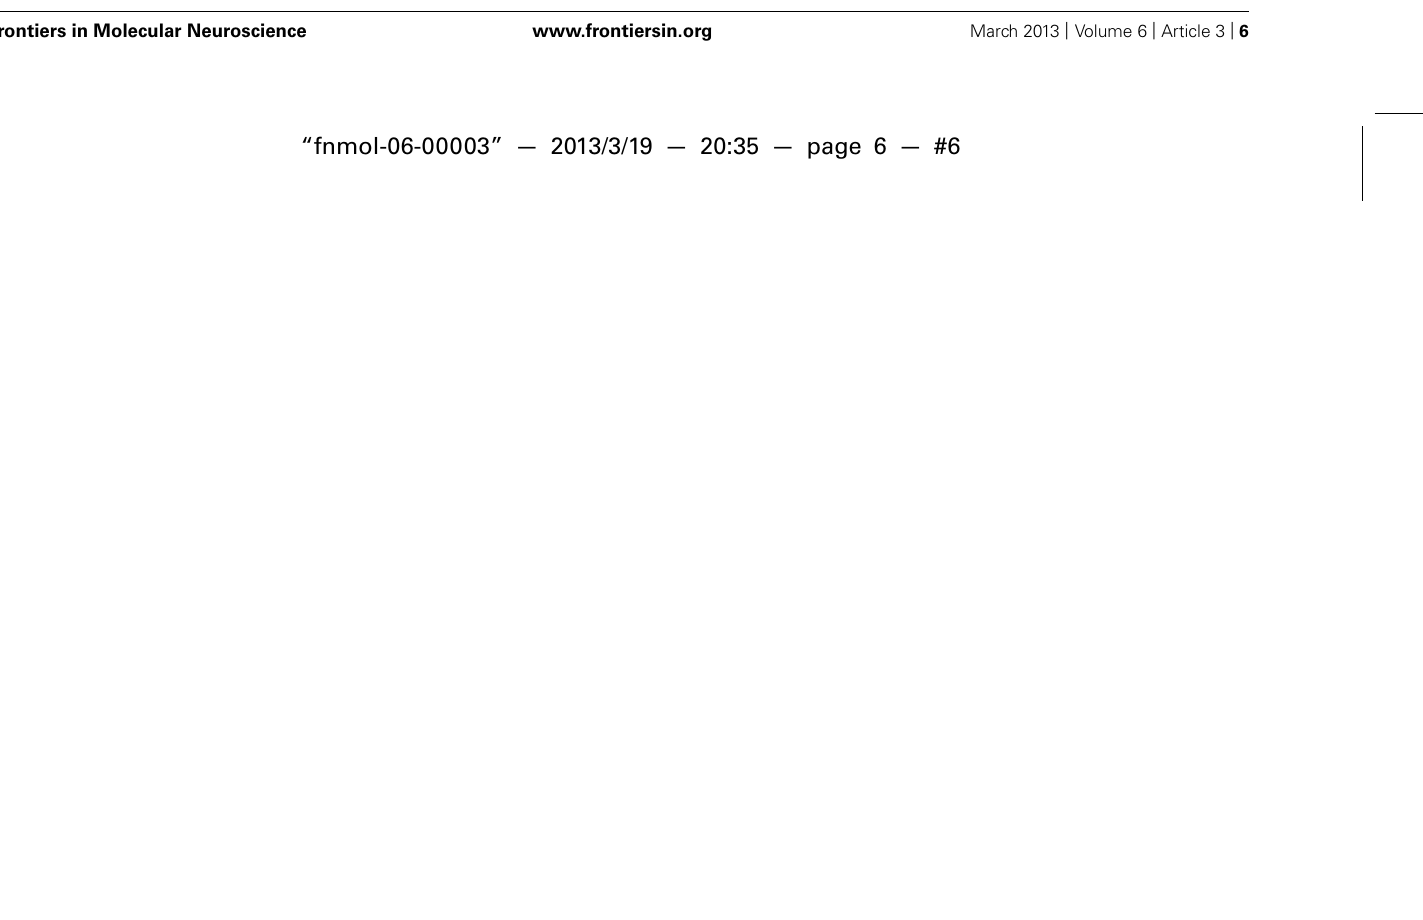
FIGURE 4 |Wavelength modulation of postsynaptic firing rate in hippocampal neurons. (A) Alternated illumination at 380 and 408 nm was spaced by a 45-s period under 500 nm to recover resting membrane voltage (red trace).Voltage recording of the APs on the postsynaptic neuron (black trace) and the calculated firing rate (green trace). Note that AP bursts are associated with light stimulation pulses, and the maximum values of firing rate depend on wavelength illumination. (B,C) Two voltage recordings from the same postsynaptic neuron expanded from (A) , during illumination at 380 nm (purple bar, up) or 408 nm (blue bar, down). (D) Plot of the averaged